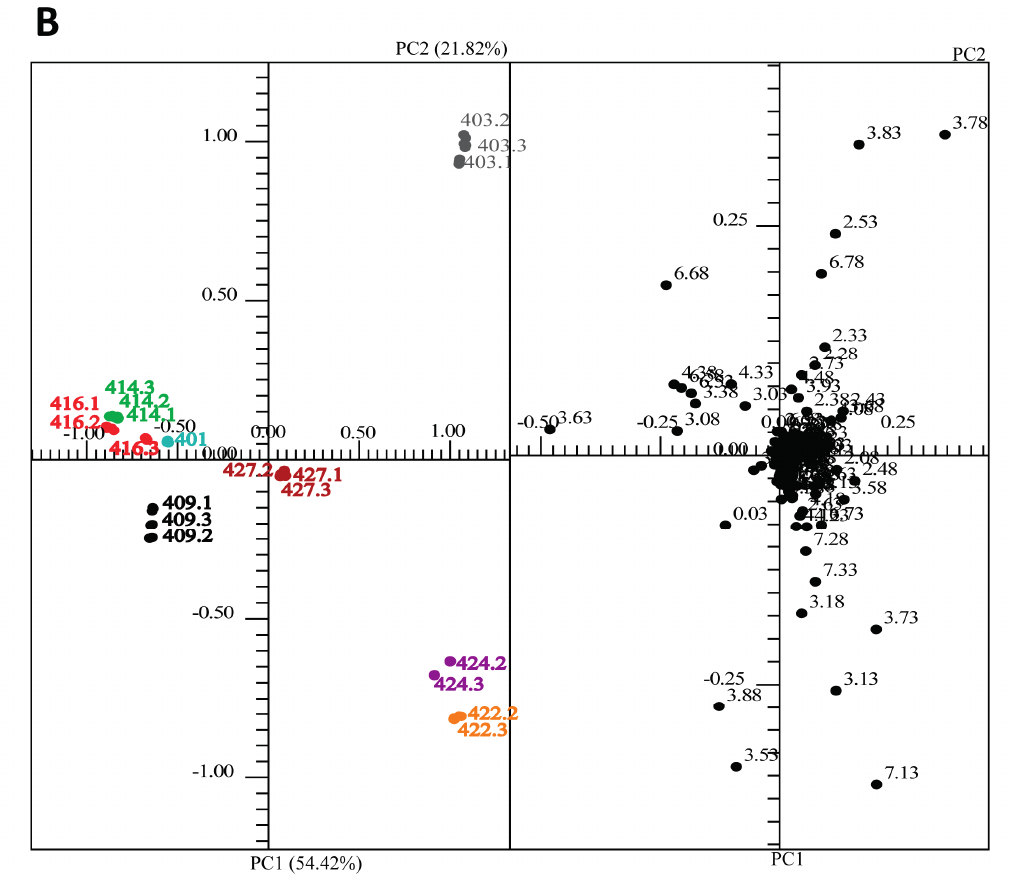
Figure 9. nrITS DNA phylogeny ( A ) and PCA of the lichen metabolites in the methanolic extracts ( B ) for representative specimens of the genus Sticta . Corresponding colors were used to indicate the same lichen species in ( A ) and ( B